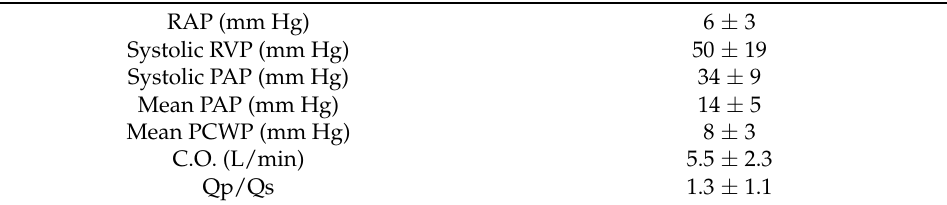
Table 2. Hemodynamic data.